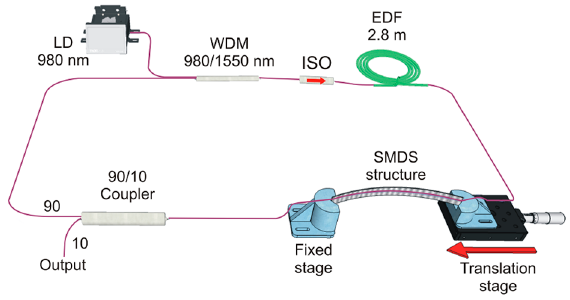
Figure 5. Experimental setup of the fiber ring EDF laser curvature sensor.